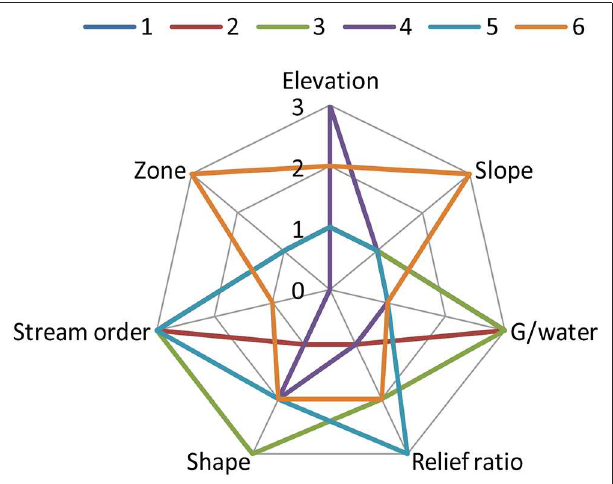
FIGURE 7 | Radar plot of HGM signatures based on qualitative median scores of morphometric variables; 1, channeled valley-bottom; 2, unchannelled valley-bottom; 3, depression; 4, flat; 5, floodplain; 6, seep. Spokes reflect variables relating to each of six HGM types, qualitatively scored according to the categories in Table 1 in conjunction with their median values in Figure 5 , where values 1–3 reflect categories as low/medium/high. Two additional variables (zone and stream order: Moolman, 2006) reflect HGM type majority membership for either upland or lowland zone (3, upland; 1, lowland) and Strahler stream order (1:500,000 scale).